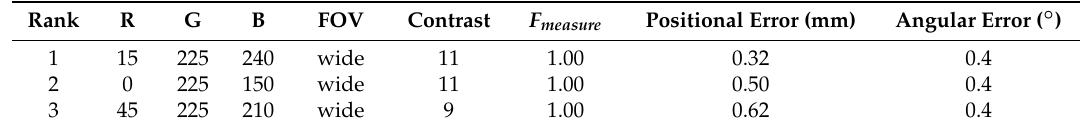
Table 5. Best-three designs of Condition III.